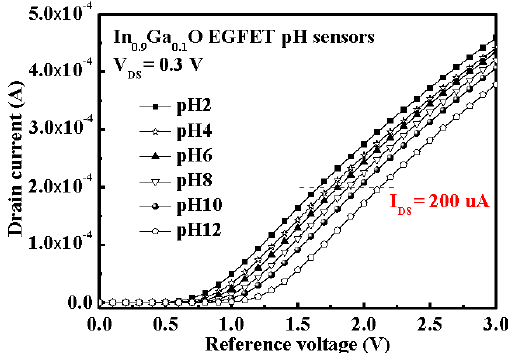
Figure 7. The transfer characteristic curves ( I DS – V REF ) characteristics of the In 0.9 Ga 0.1 O EGFET pH sensors.